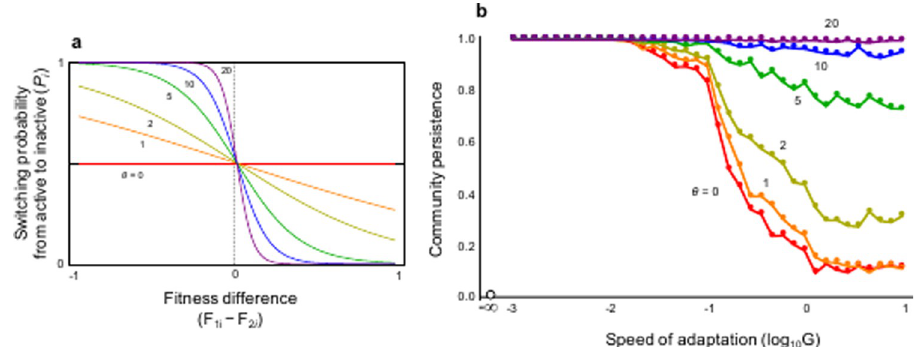
Fig 1. Plastic changes in activity modes and community stability. (a) Switching function of activity modes, P i (Eq 2 in Methods); (b) Effects of the speed and accuracy of phenotypic switching on community stability. See S8 Fig for the confidence interval. The white circle in (b) is the result of no adaptation. N = 40 and C = 0.3. Parameters are R = 0.04, E = 0.01, A 1 = 0.1, and A 2 =